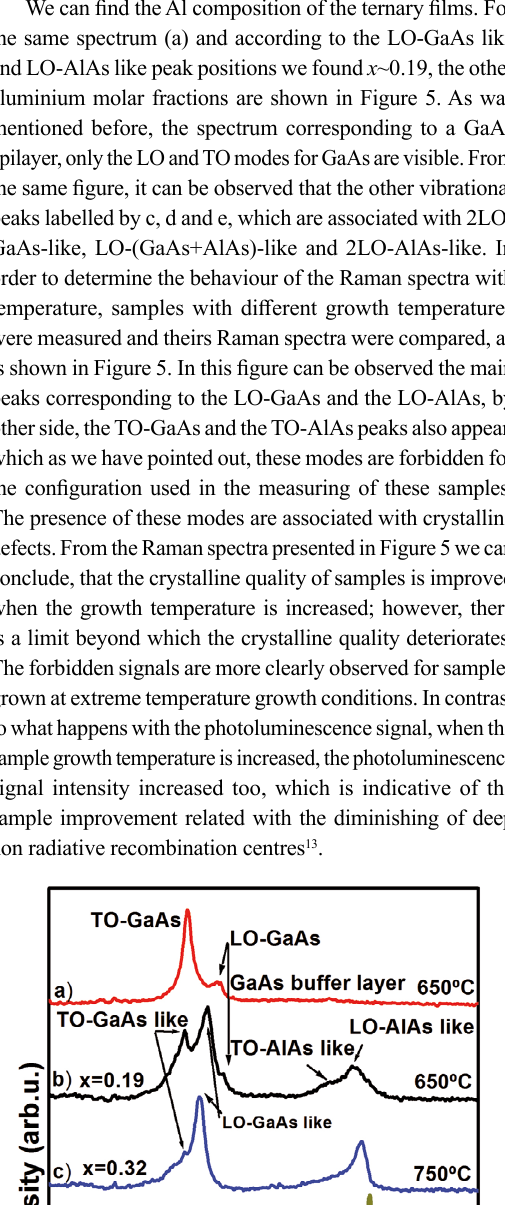
Ga As layers that were x 1-x